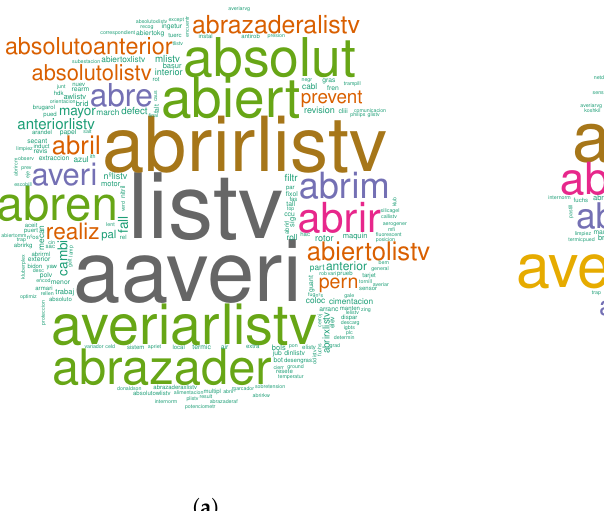
Figure 4. Word clouds with the top 200 most frequent words for the gearbox before ( a ) and after ( b ) the replacement. In this case, even if the most important words are similar, the clusters have changed. However, both word clouds seem similar, and further analysis has to be done in order to obtain clear